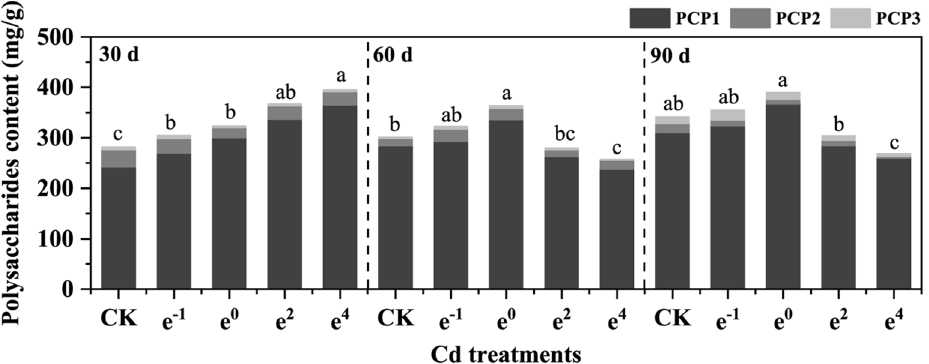
Figure 5. Polysaccharide content of Polygonatum sibiricum. PCP1: First step polysaccharides in fractionated extraction. PCP2: Second step polysaccharides in fractionated extraction. PCP3: Third step polysaccharides in fractionated extraction.